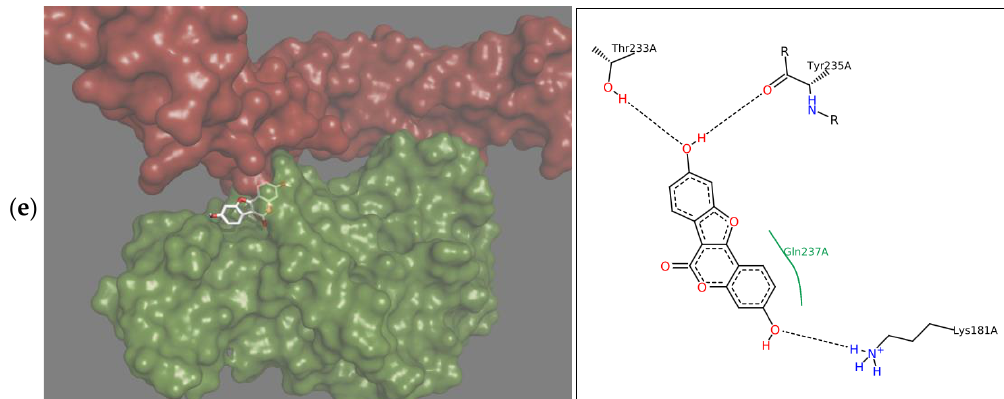
Figure 2. Depiction in 3D on the right (green Receptor activator of nuclear factor-κB ligand (RANKL), magenta osteoprotegerin) and in 2D on the left of the main interactions established between the active site of RANKL and: ( a ) Daidzein; ( b ) Formononetin; ( c ) Genistein; ( d ) Biochanin A; ( e ) Coumestrol. Continuous lines represent hydrophobic interactions, while black dashed lines show hydrogen bonds and dashed green lines π-π interactions.